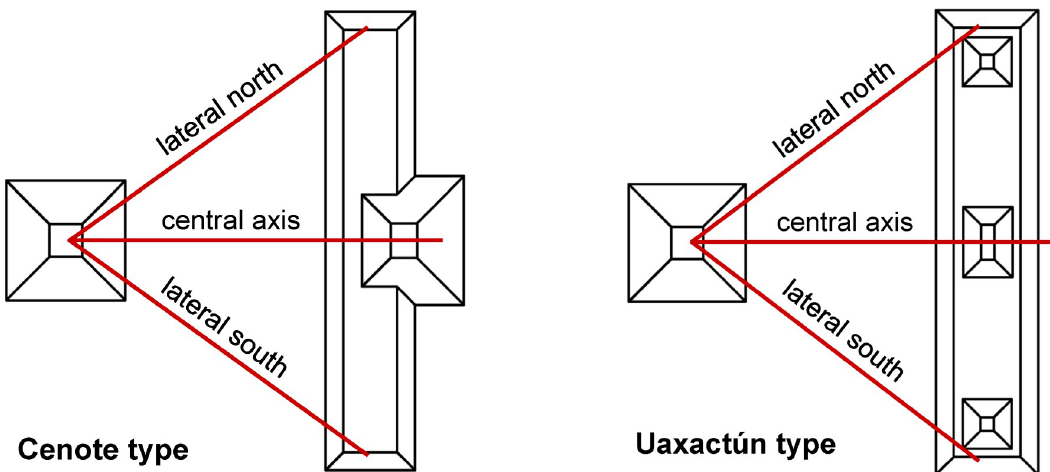
Fig 2. Schematic ground plans of two most common types of E Groups, showing the alignments that have been measured and